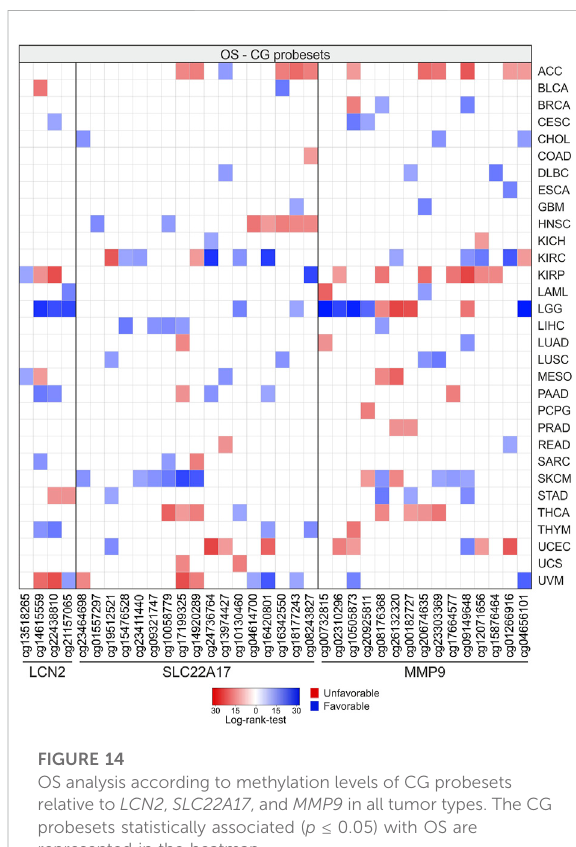
FIGURE 14 OS analysis according to methylation levels of CG probesets relative to LCN2 , SLC22A17 , and MMP9 in all tumor types. The CG probesets statistically associated ( p ≤ 0.05) with OS are represented in the